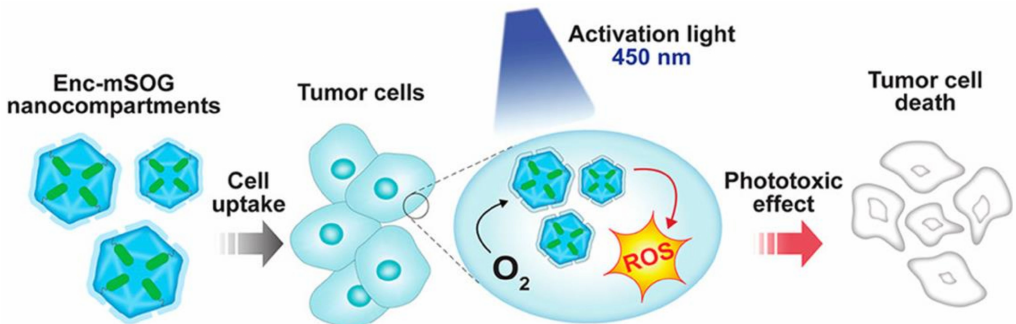
Figure 4. An EncTm nanoreactor with a reversed oxidative stress response. Overview for delivery, activation, and phototoxic effect of miniSOG-loaded EncTm nanocompartments. Via endocytosis, tumor cells take up photosensitizing EncTm-miniSOG nanocompartments; following blue-light excitation, the nanocompartments photoconvert intracellular O 2 to cytotoxic 1 O 2 (singlet oxygen) that induces tumor cell death. Reprinted with permission from [103]. Copyright 2021 American Chemical Society.